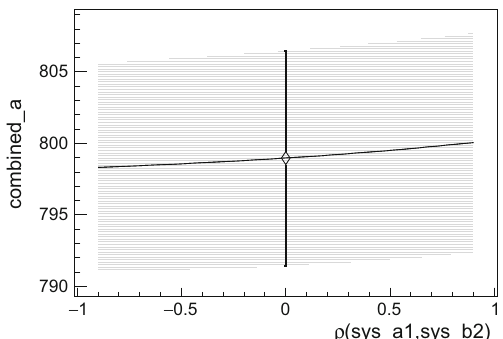
Fig. 14 Combined value for combined_a for a scan of the corre- lation coefficient for sys_a1 and sys_b2 . The open marker shows the result obtained with the nominal assumption and its uncertainty.The shaded area represents the uncertainty associated to the scanned depen- dence, indicated by a continuous line. All values are obtained with the example